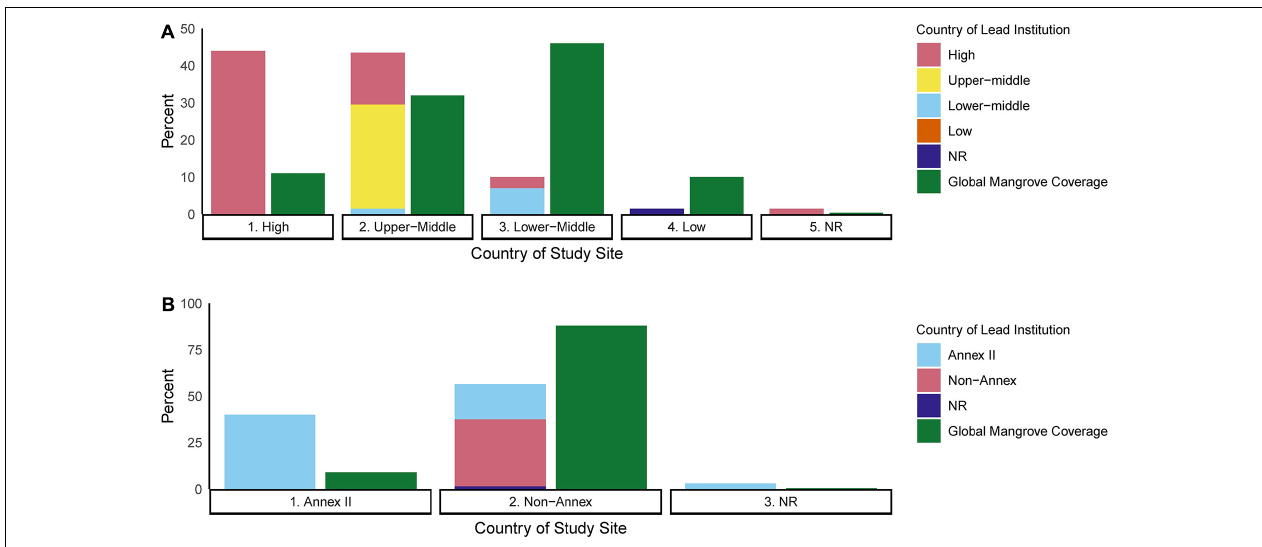
FIGURE 1 | (A) Percentage of studies conducted within each country by income level designation from the World Bank Data (2019). The income designation by the World Bank is not recorded (NR) for the following countries and territories: Mayotte, Anguilla, Guadalupe, Bonaire, Sint-Eustatius, Saba, and Martinique. In green, the percentage global mangrove coverage from Bunting et al., 2018. (B) The distribution of studies based on the UNFCCC designations of the country where the study occurred and the country that led the study (lead institution). Percentages are shown in relation to the all studies per UNFCCC party ( n = 72). Countries or territories that are not listed as a party to the UNFCCC (NR) are French Guiana and Turks and Caicos Island. Percentage of global mangrove coverage by UNFCCC party is also shown.